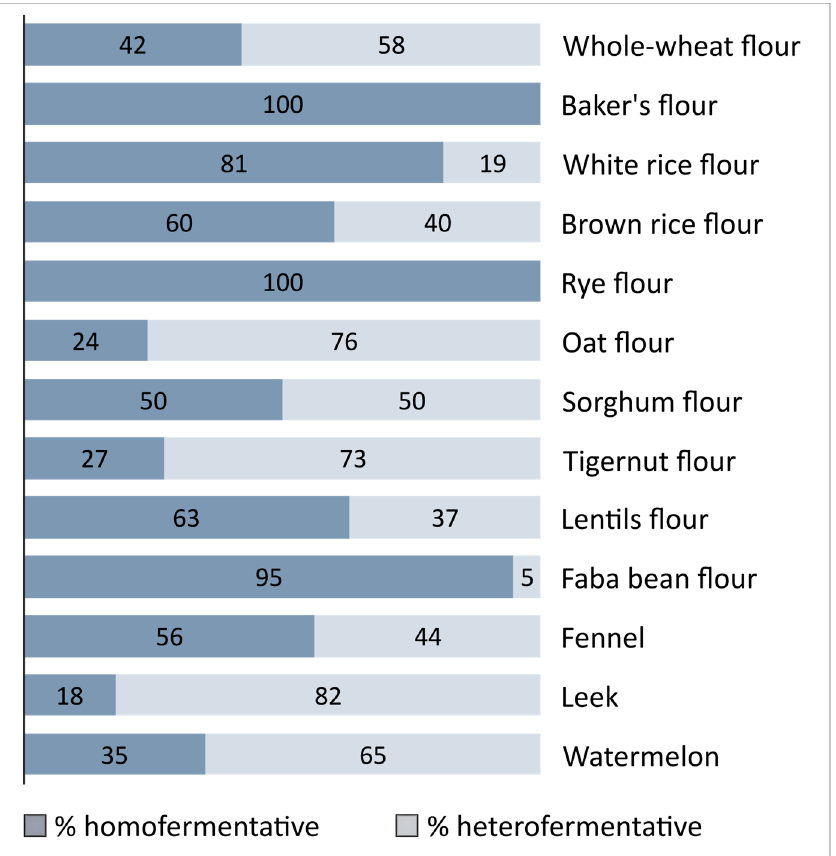
Figure 1. Percentage of the homo- and hetero-fermentative LAB strains isolated from a variety of sourdoughs, fruit, and vegetables. Fermentation assay was performed via inverted Durham tube assay using MRS5 medium and 20% glucose as the sole carbon source.